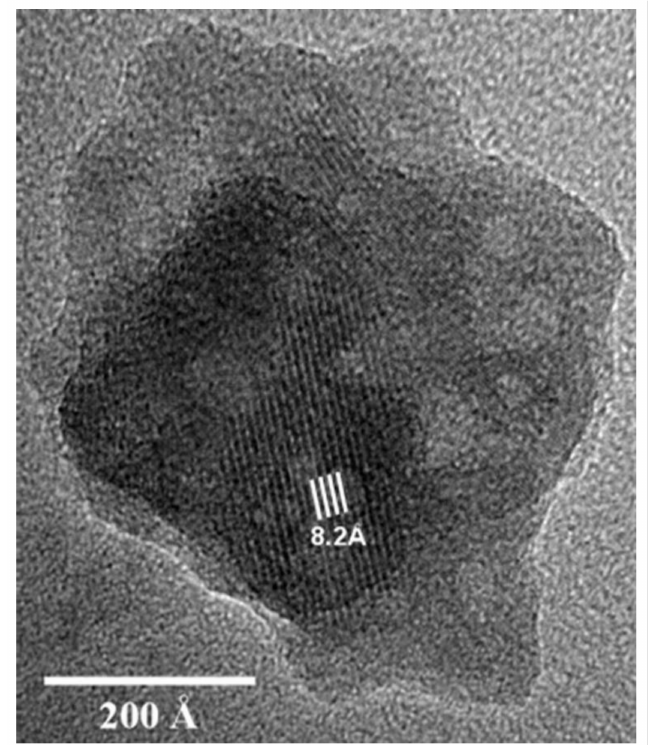
Figure 22. Lattice-fringe image showing d -spacing of 8.2 Å for an OPC mortar sample aged for 14 days [108]. Reproduced with permission from La Iglesia, A. et al., Constr. Build. Mater.; Published by Elsevier, 2012.